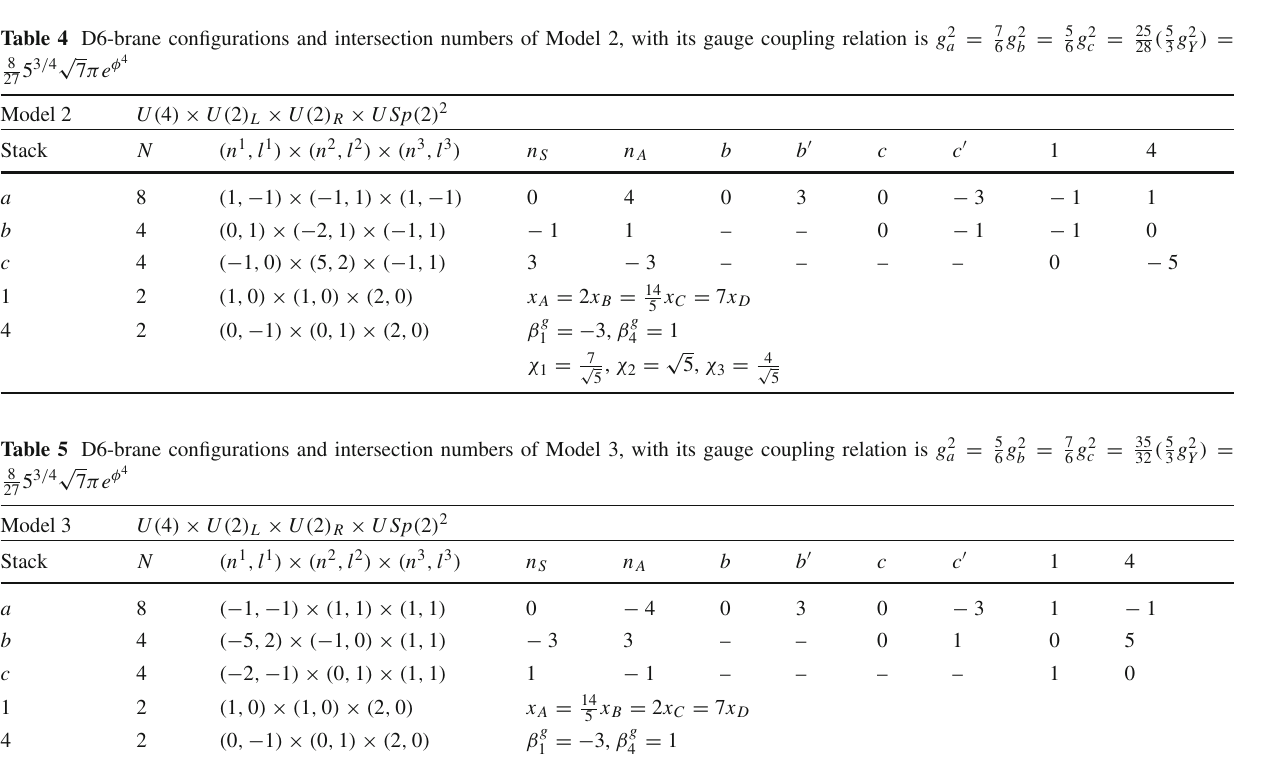
Table 4 D6-brane configurations and intersection numbers of Model 2, with its gauge coupling relation is g 2 a = 7